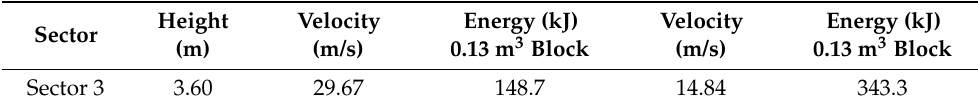
Table 5. Height and velocity (percentile 95%) and kinetic energy—Phase 1.